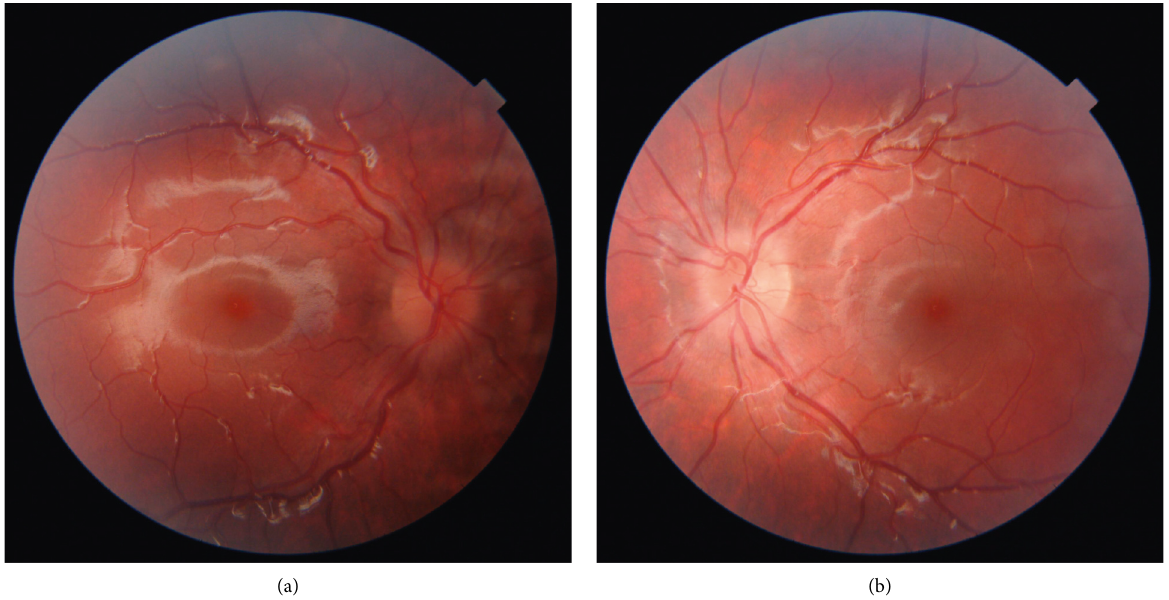
Figure 2: The fundus of the right (a) and of the left (b) eye after three weeks—resolution of the optic disc